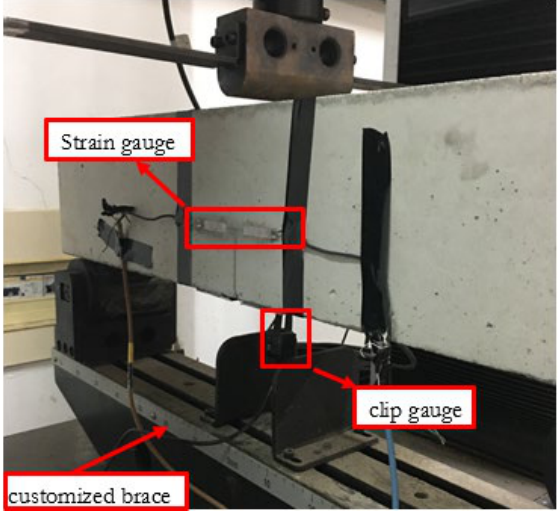
Figure 3: Testing